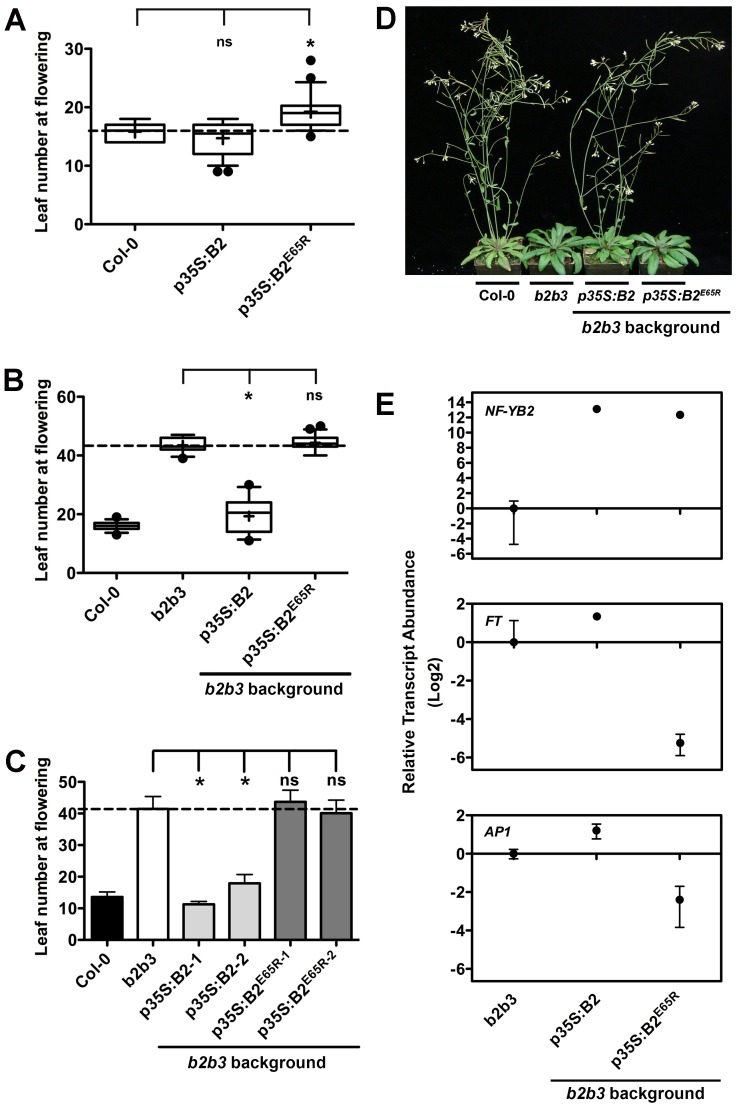
p35S:NF-YB2E65R cannot rescue the nf-yb2 nf-yb3 late flowering phenotype.A) Flowering time quantification of 15–20 randomly selected T1 p35S:NF-YB2 and p35S:NF-YB2E65R plants in the Col-0 background. B) Flowering time quantification of 15–20 randomly selected T1 p35S:NF-YB2 and p35S:NF-YB2E65R plants in the nf-yb2 nf-yb3 background. C) Flowering time quantification of two independent, stable T3 p35S:NF-YB2 and p35S:NF-YB2E65R plant lines in the nf-yb2 nf-yb3 background (n≥12). D) Representative plants of p35S:NF-YB2 and p35S:NF-YB2E65R in the nf-yb2 nf-yb3 background. E) Relative transcript abundance of NF-YB2, FT and AP1 in stable T3 p35S:NF-YB2 and p35S:NF-YB2E65R plants in the nf-yb2 nf-yb3 background. Asterisks in 3A, 3B and 3C represent significant differences derived from one-way ANOVA (P < 0.05) followed by Dunnett’s multiple comparison post hoc tests against nf-yb2 nf-yb3.